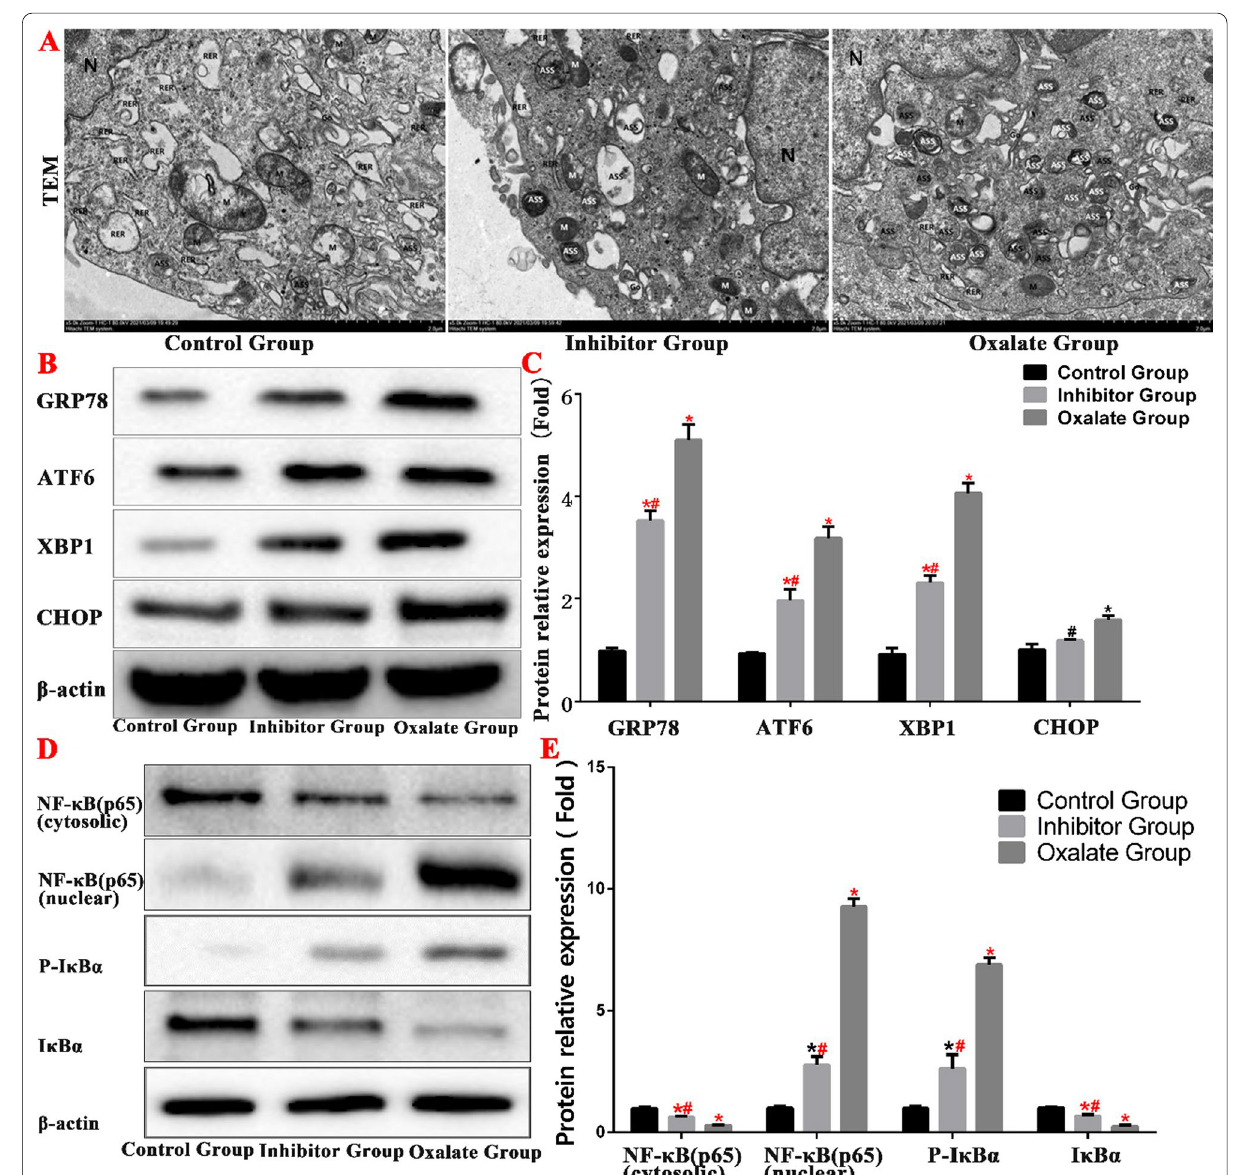
Fig. 8 Oxalate activates the NF-κB pathway by stimulating ERS in HK-2 cells. A Ultrastructure observation of each group under transmission electron microscope. B , C Western blot was used to detect the expression of ERS-related proteins in each group. D , E Western blot was used to detect the expression of NF-κB pathway proteins in each group. (*compared with normal Control group, P < 0.05.* (Red) Compared with Control group, P < 0.01. # Compared with oxalate group, P < 0.05. #(Red) Compared with oxalate group, P <